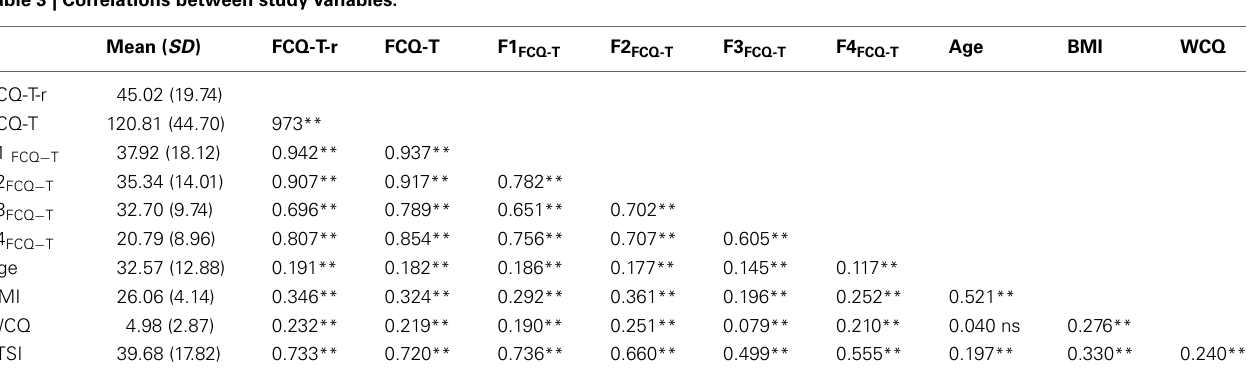
Table 3 | Correlations between study